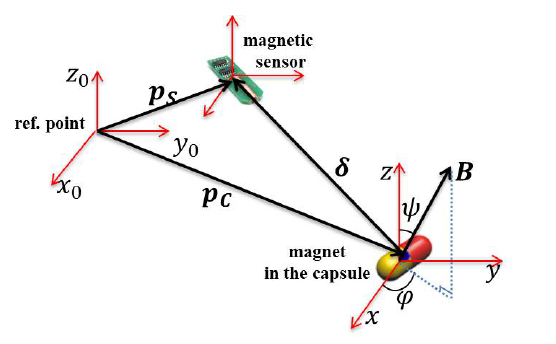
Figure 8. Coordinate frame of a magnet for WBC